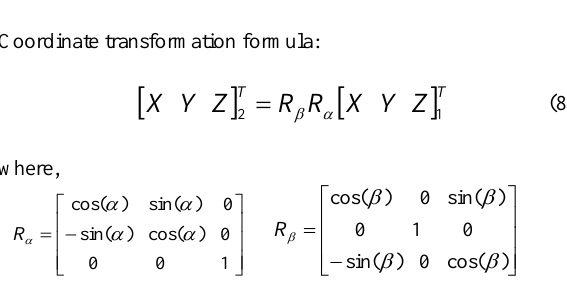
Fig.3 Coordinate transformation